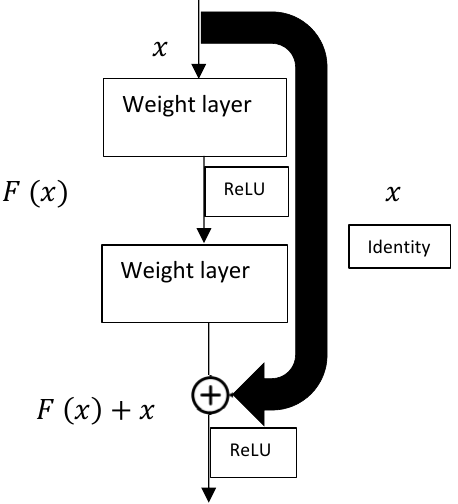
Figure 4. Residual learning model (Adapted from ref. [4]).